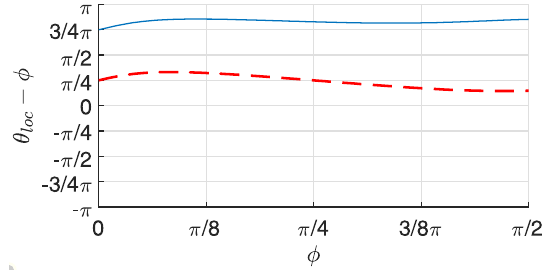
Figure 11. Difference between θ tion of φ under uniaxial compression